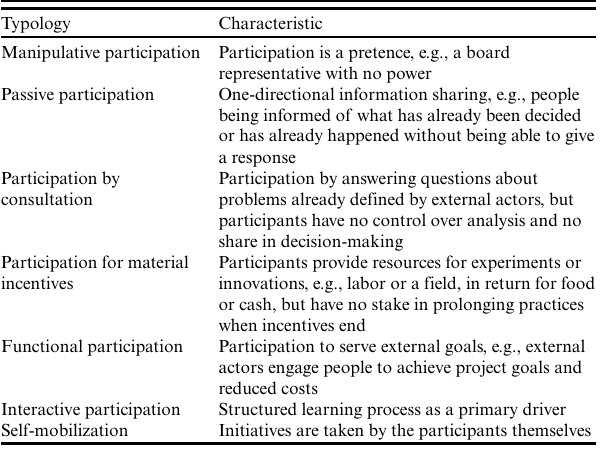
Table 1. Interpretation and summary of Pretty’s (1995) typology of participation.